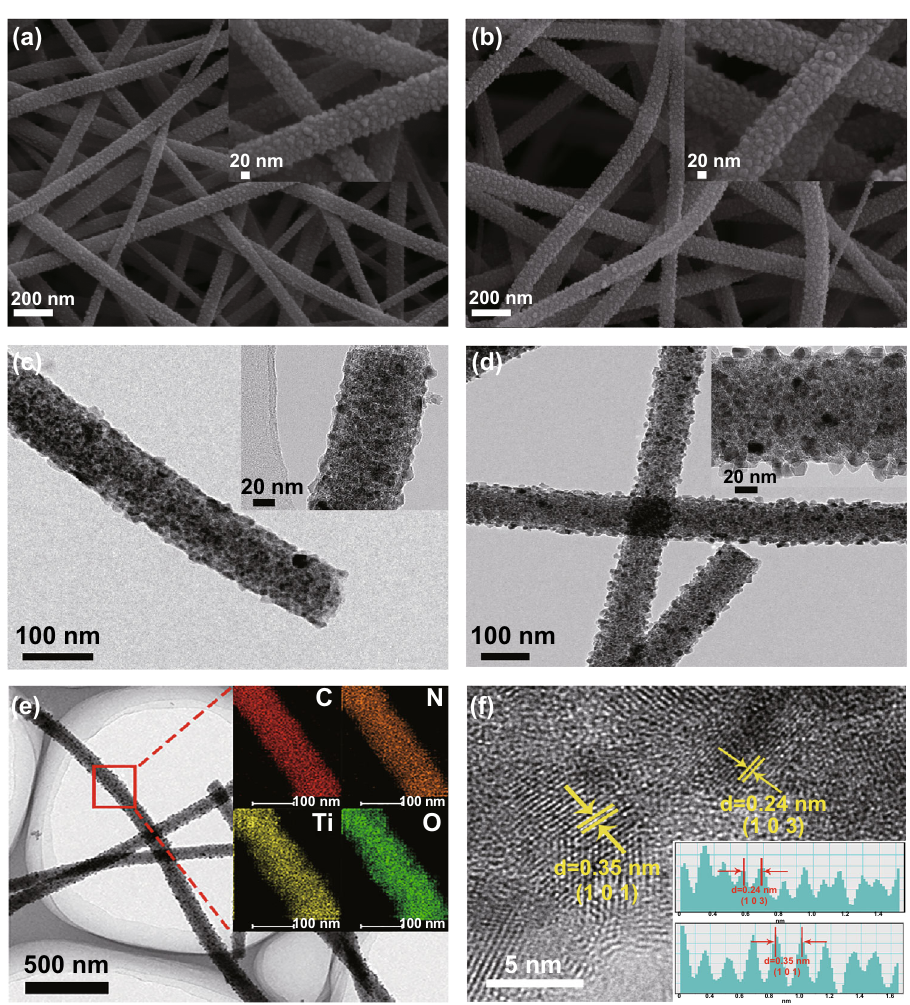
Fig. 2 SEM images of a TiO 2 –C NFs and b TiO 2 /N–C NFs. TEM images of c TiO 2 –C NFs and d TiO 2 /N–C NFs. e TEM elemental mapping images of C, N, Ti, and O in TiO 2 /N–C NFs. f HRTEM image of TiO 2 /N–C NFs with lattice spacing (the inset shows statistical tables of the interplanar crystal